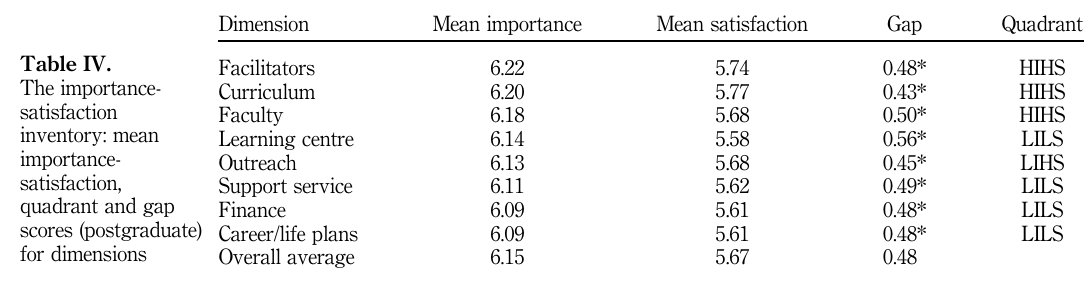
Table IV. The importance- satisfaction inventory: mean importance- satisfaction, quadrant and gap scores (postgraduate) for